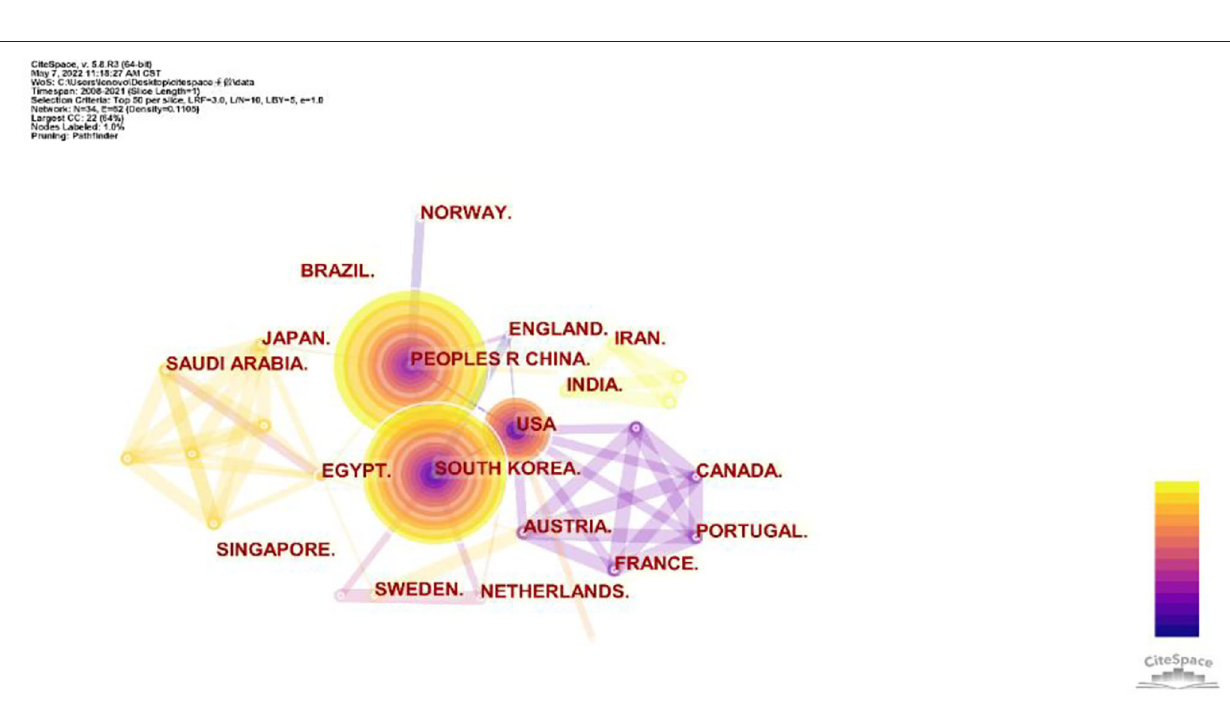
Frontiers in Neurology | www.frontiersin.org 4 July 2022 | Volume 13 | Article